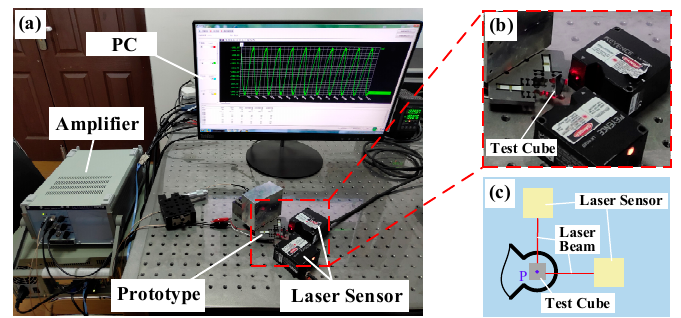
Figure 13. Experimental system for testing the motion trajectory of the output end of the flexure hinge mechanism: ( a ) overall experimental devices, ( b ) the local detailed graph of the actuator and the laser sensors, and ( c ) the test schematic diagram.